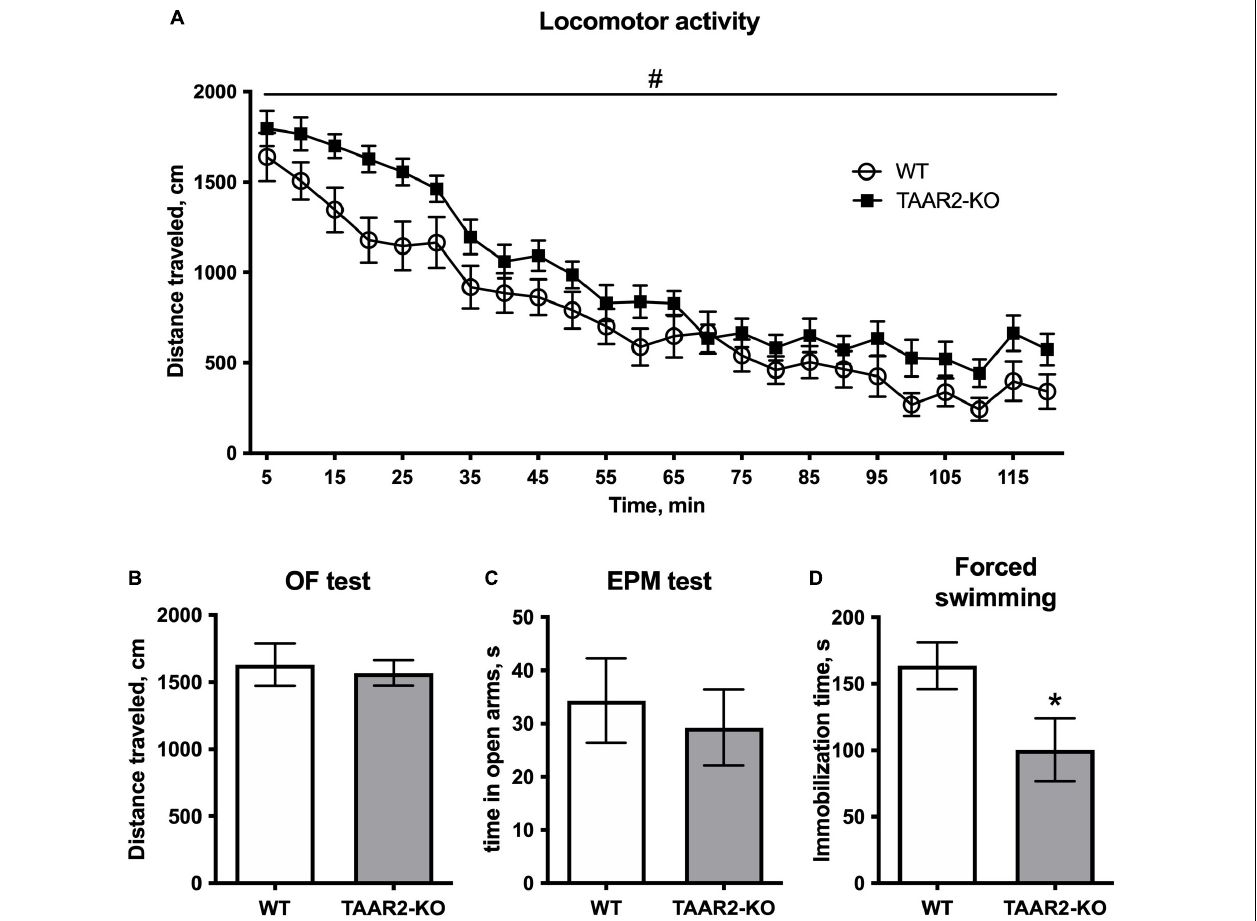
FIGURE 4 | | The behavioral parameters of TAAR2-KO vs. wild-type (WT) mice. (A) Locomotor activity for 2 h, distance traveled, cm; (B) Distance traveled in open field test for 5 min, cm; (C) Time spent in open arms in the elevated plus-maze test; (D) Immobilization time in the forced swimming test. All data presented as mean ± SEM. ∗ p < 0.05, t -test. # p < 0.05, two-way ANOVA.